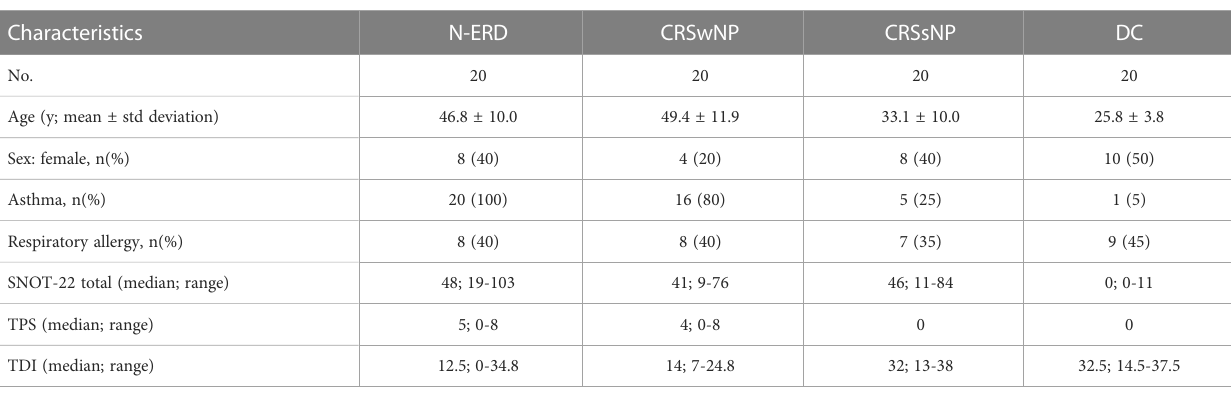
TABLE 1 Demographics and clinical characteristics of the study